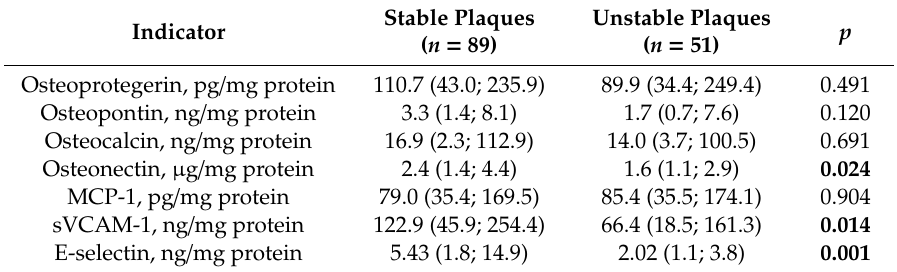
Table 2. A comparison of calcification markers and endothelial-dysfunction markers between stable and unstable atherosclerotic plaques (median (interquartile range): Me (25%; 75%)).